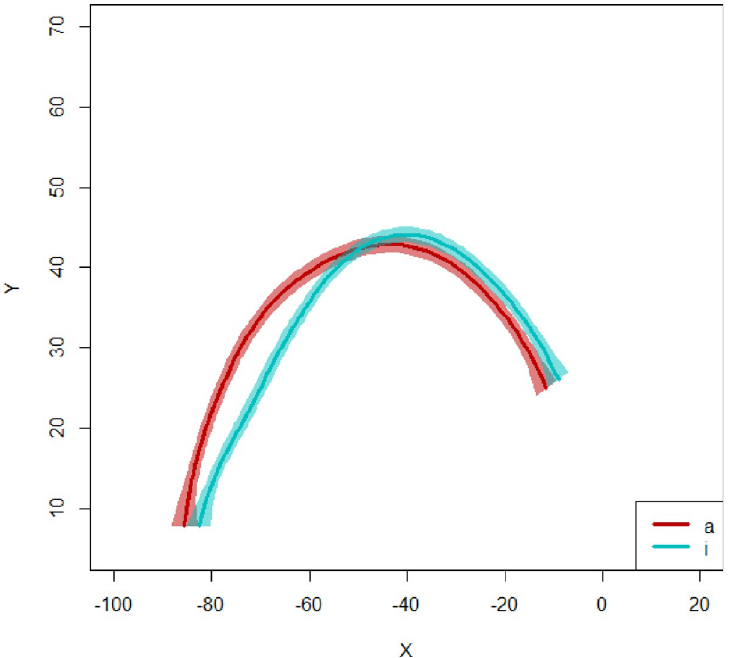
Fig 2. Illustration of average splines corresponding to midsagittal tongue contours with 95% confidence intervals, for a child participant, for / ε / in / ε bi/ (blue) and in / ε ba/ (red). X and Y are in mm.